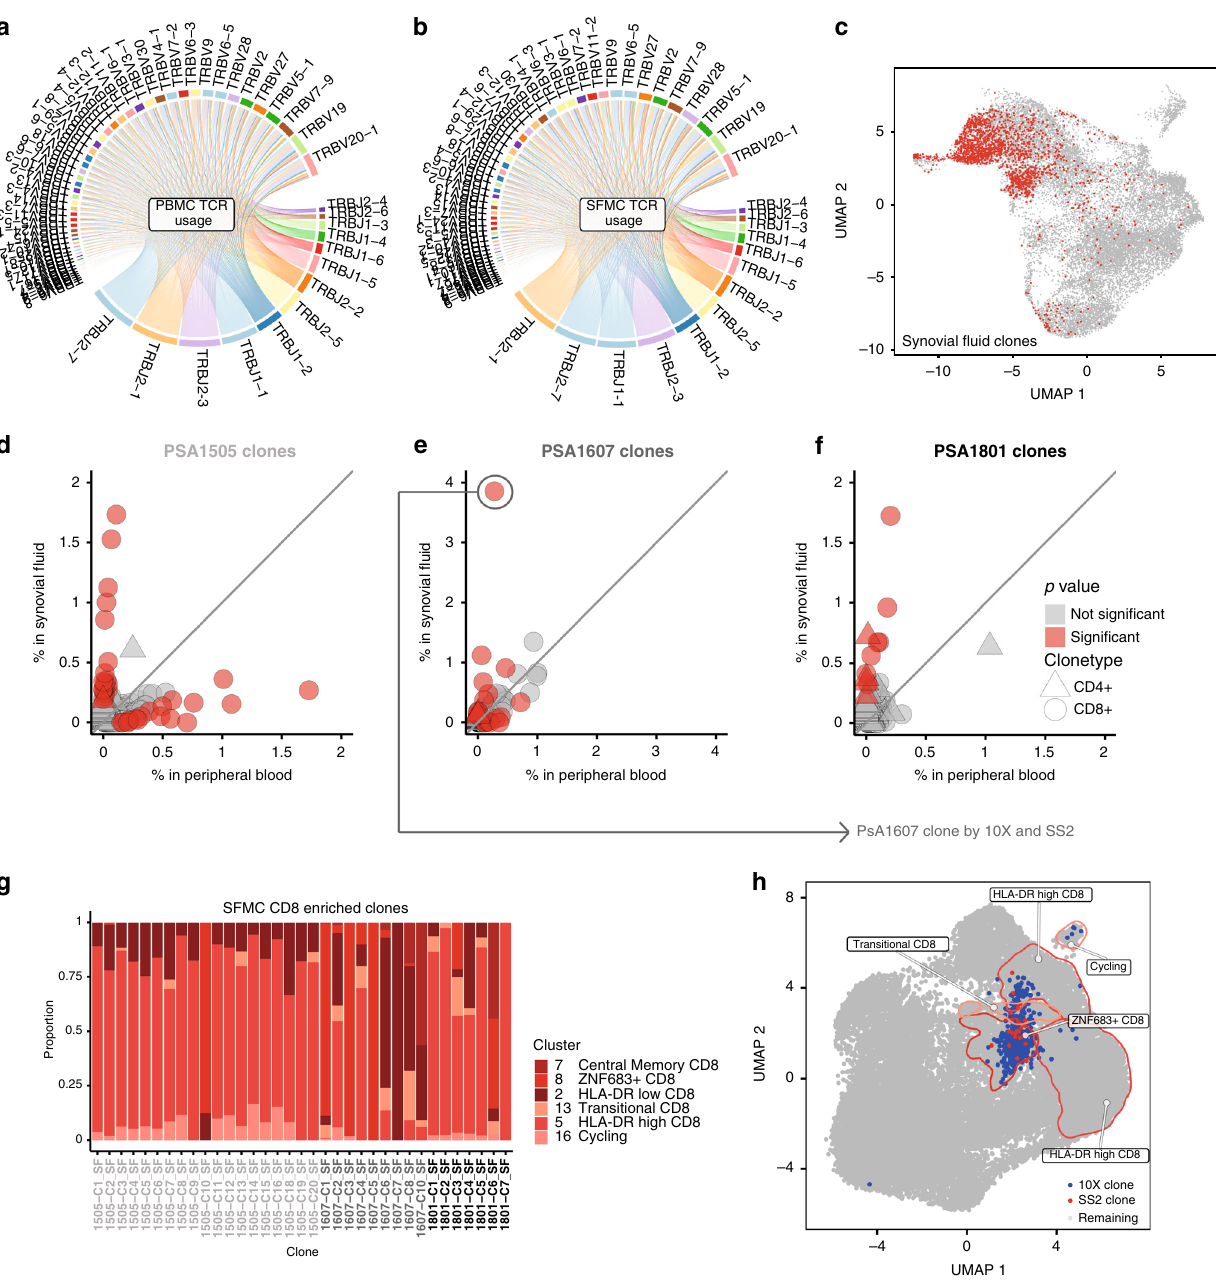
Fig. 3 Clonal expansion of CD8 T cells in psoriatic arthritis. a , b TCR beta-chain V and J-gene usage in PsA blood and synovial fl uid generated from 10× 5 ′ data of patients PSA1505, PSA1607 and PSA1801. V and J segments are represented by arcs, scaled in size to their combined usage by all patients within each sample type, and giving equal weight to each patient. V – J pairings are represented by ribbons. Plot generated using VDJtools (v1.2.1) 36 . c UMAP of PsA synovial fl uid CD4 and CD8 T cells from three patients with clonally expanded cells highlighted in red. Clonally expanded cells in synovial fl uid associated most strongly with HLA-DR-high CD8, cycling and ZNF683 + CD8 clusters (odds ratios 12.6, 4.73 and 3.66; adjusted p value 0, 8.7E − 19 and 6.1E − 64, respectively; two-sided Fisher ’ s exact test with Bonferroni correction using R stats package; Supplementary Data 7a). d – f Individual clonal expansion across blood and synovial fl uid for three PsA patients based on 10× 5 ′ data. Circles represent CD8 clonotypes, triangles represent CD4 clonotypes. Data points coloured red show signi fi cantly expanded clonotypes (adjusted p value ≦ 0.05). Two-sided Fisher ’ s exact test, Benjamini – Hochberg correction. g Cluster assignment of enriched CD8 clones in PsA synovial fl uid from three patients (PSA1505, PSA1607 and PSA1801). h UMAP plot of integrated memory T cells from one donor (PSA1607), including cells from 5 ′ 10× and SS2 datasets (Supplementary Fig. 8). Synovial CD8 T cells from the clone most enriched in synovial fl uid for this patient are highlighted in blue for the 10× data set and red for the SS2 data set. Source data are provided as a Source Data fi